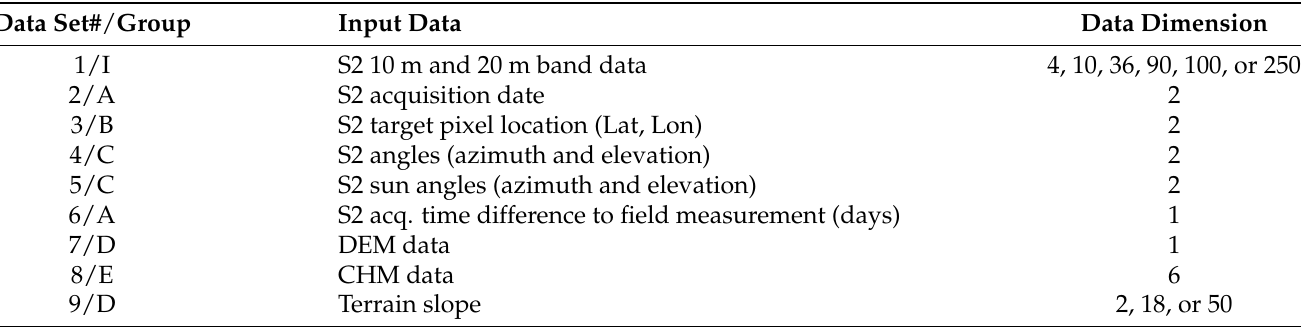
Table 3. The different input data used as model predictor variables. Each data source was used as model inputs either separately (referred to by data set number) or in data groups (referred to by group code). The dimensions of the S2 image data varied depending on the image channels used as well as the image sampling window size (1 × 1, 3 × 3 or 5 × 5 pixels), which also affected the dimensions of terrain slope data. The CHM statistics (mean, median, stdev) were computed for 1 × 1 and 3 × 3 S2 window